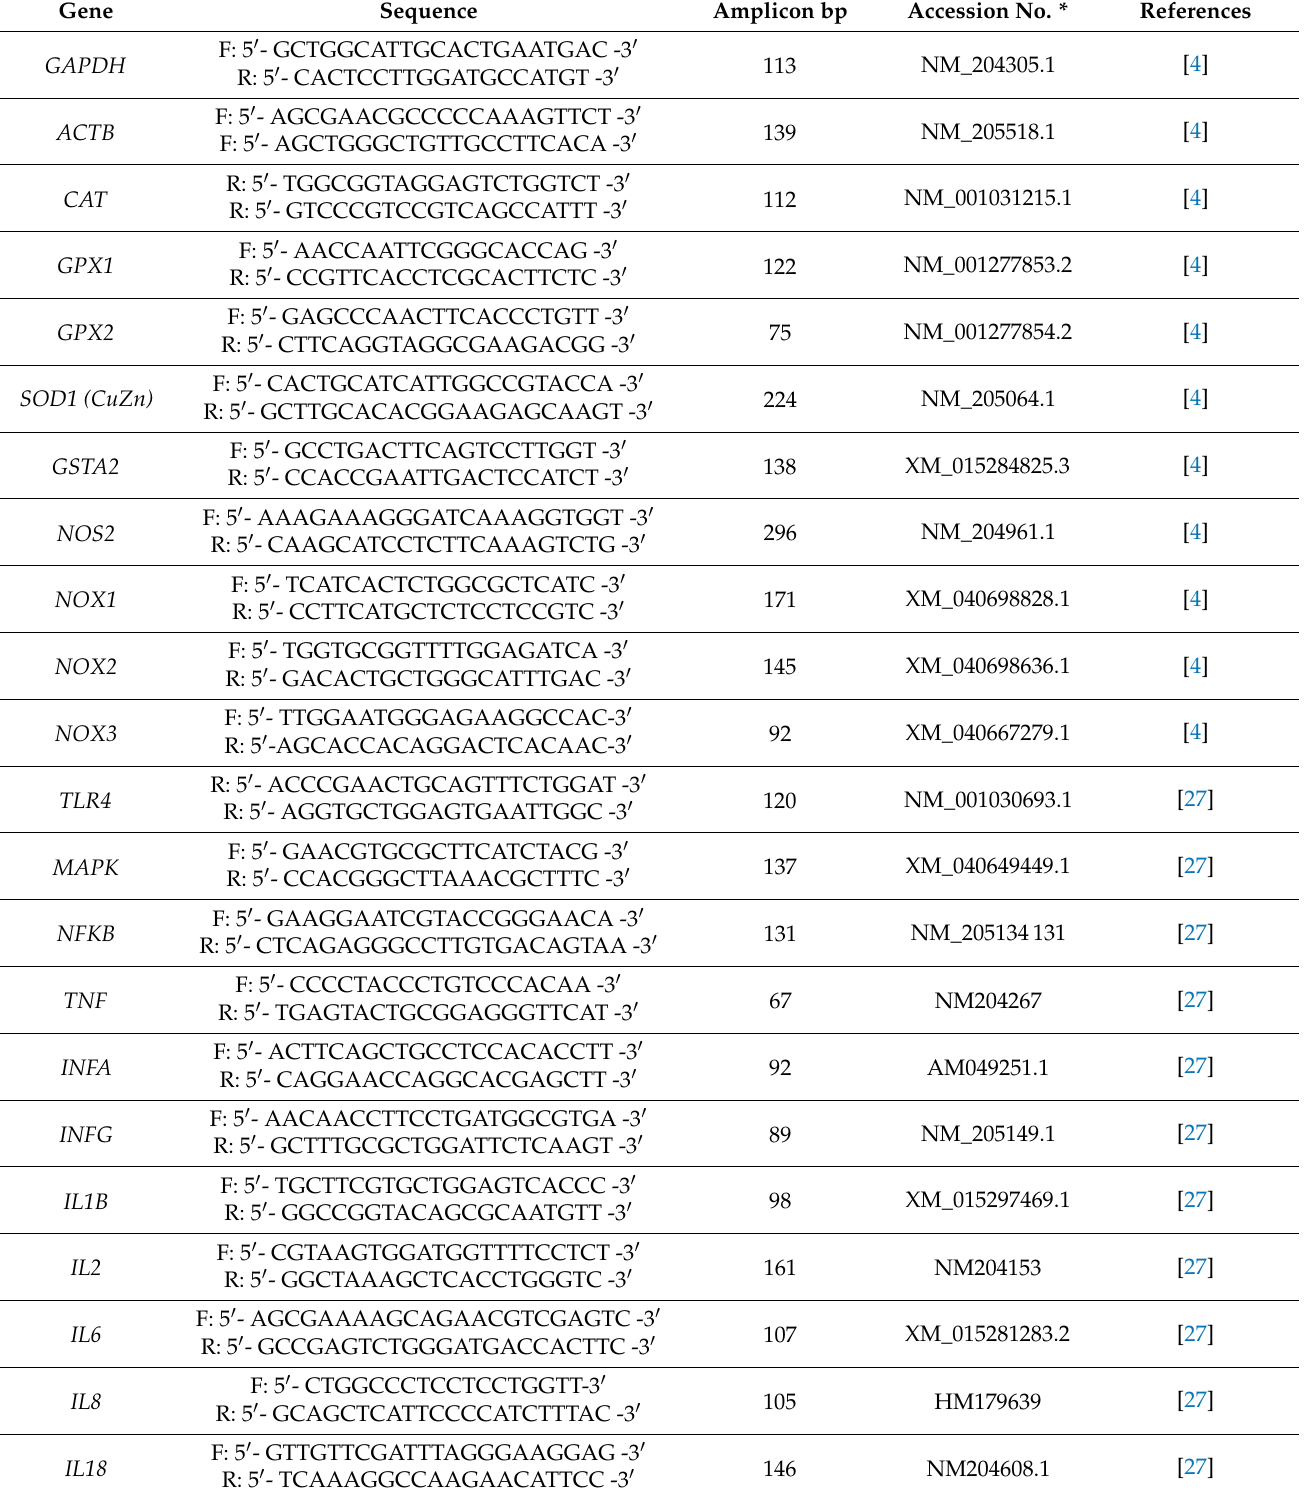
(Table 3). The specificity of each pair of primers was tested through the dissociation curves, and the amplification products were subjected to agarose gel electrophoresis (2%) to confirm the production of a single amplicon per reaction. Table 3. Sequences and relative positions of primers for target genes used in real-time